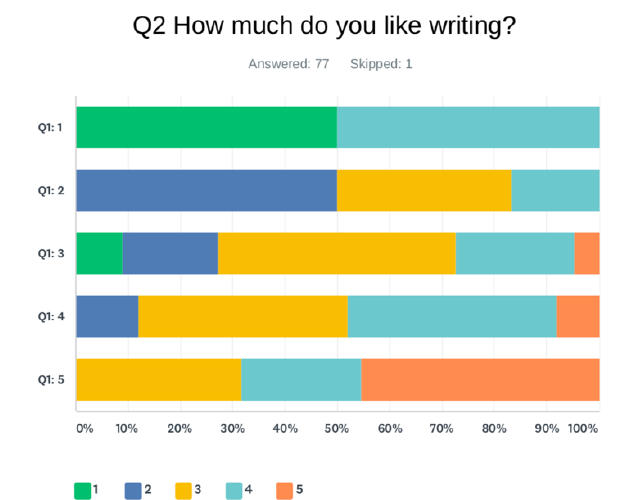
Figure 4. Question 2 split by scores to “Q1. How much experience do you have with writing overall, on a scale of 1-5, with 5 being the